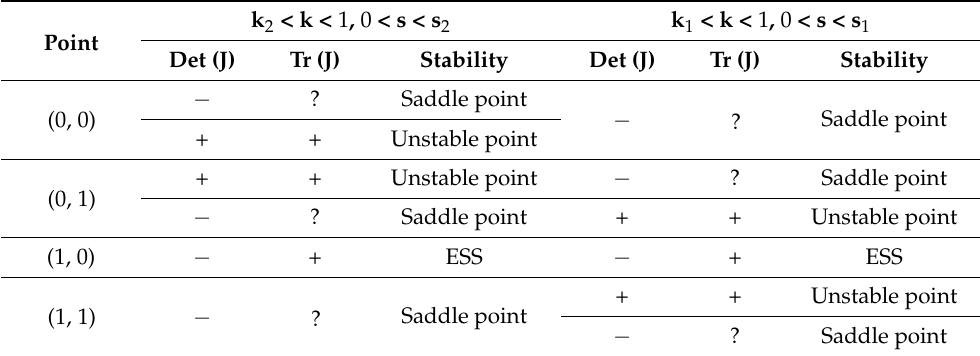
Table 17. Stability analysis of the points in case